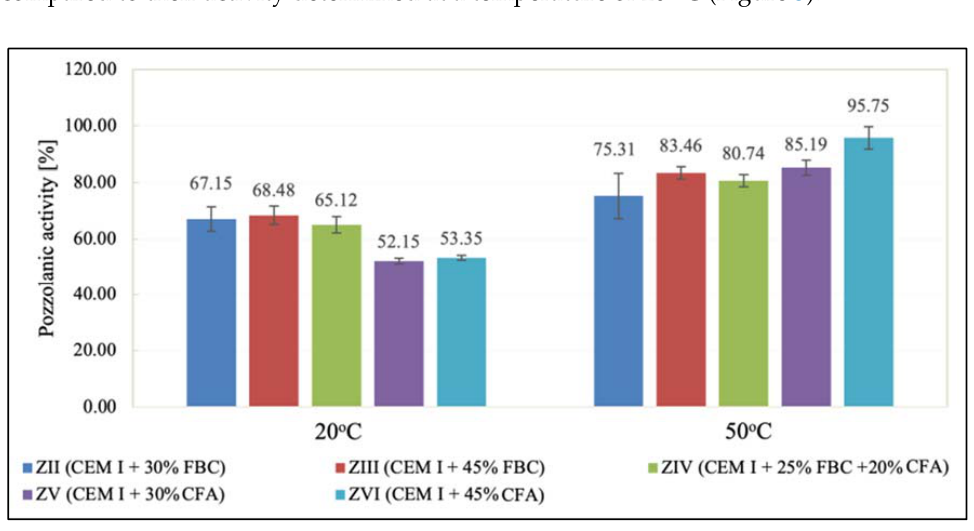
Figure 3. Pozzolanic activity index for fluidized-bed-combustion fly ash and siliceous fly ash determined using the Frattini method.